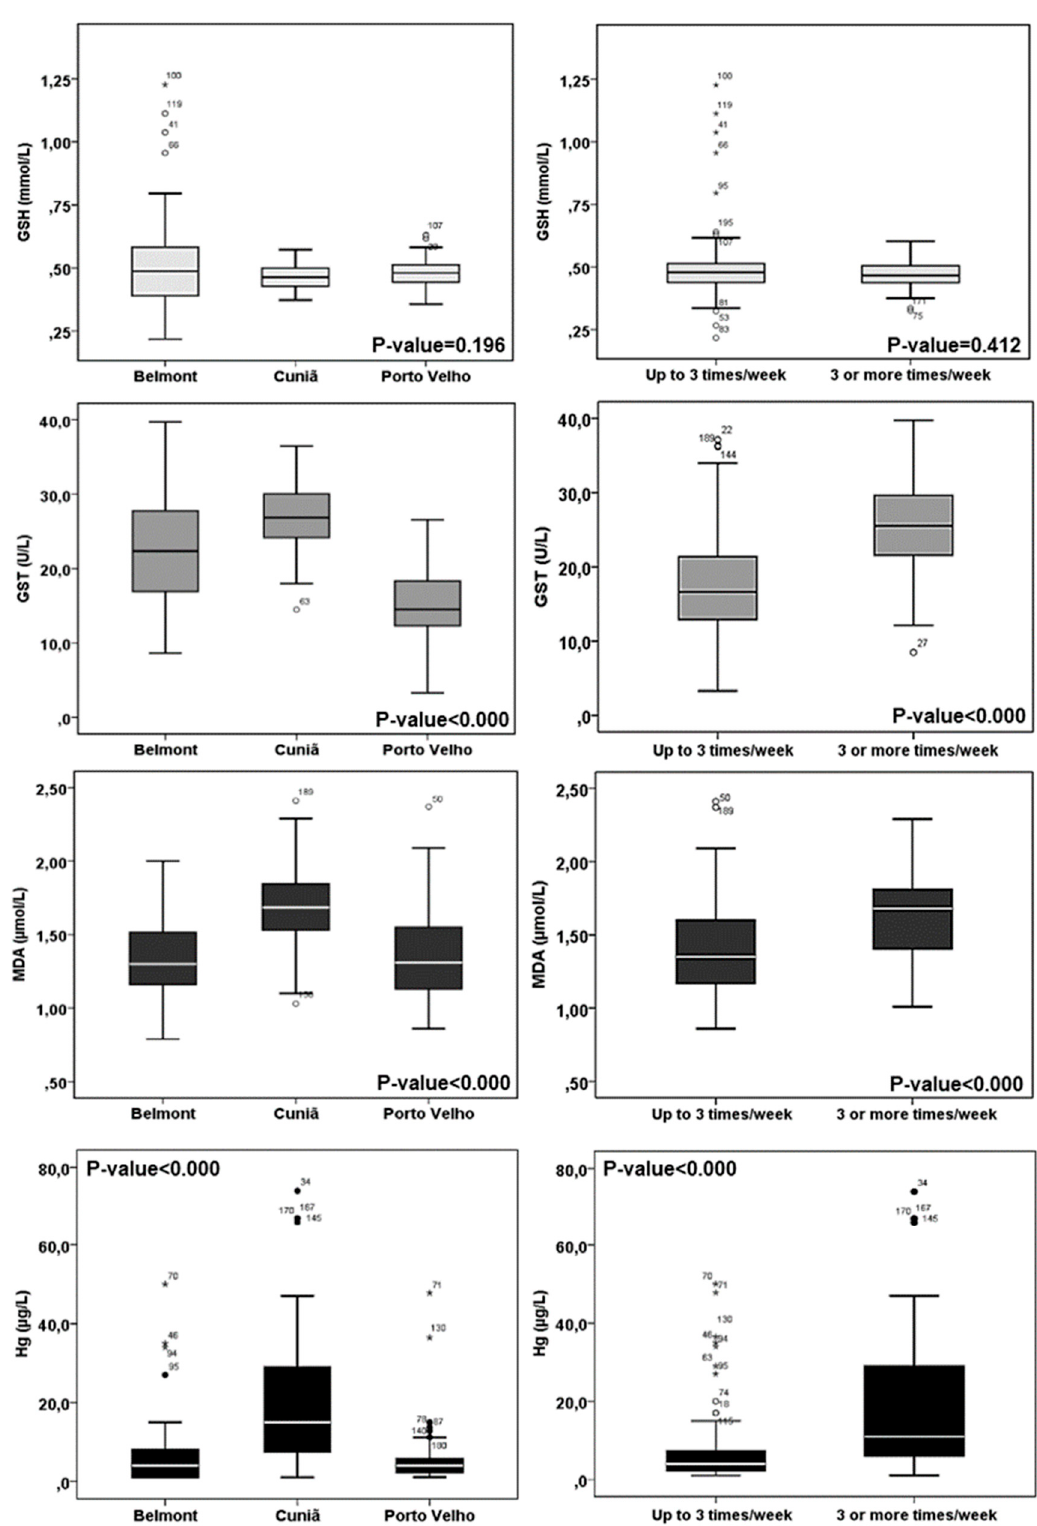
Figure 3. Boxplots displaying the results of the analyzed biomarkers (GSH, GST, MDA, and Hg), in the study population, per juvenile community and fish consumption frequency at the Madeira basin. Small dots outside the boxplots represent the outliers. Hg-B presented a moderate and significant correlation with GST (r = 0.39, p -value < 0.001) and a weak but significant correlation with MDA (r = 0.23, p -value < 0.001). MDA was moderately and